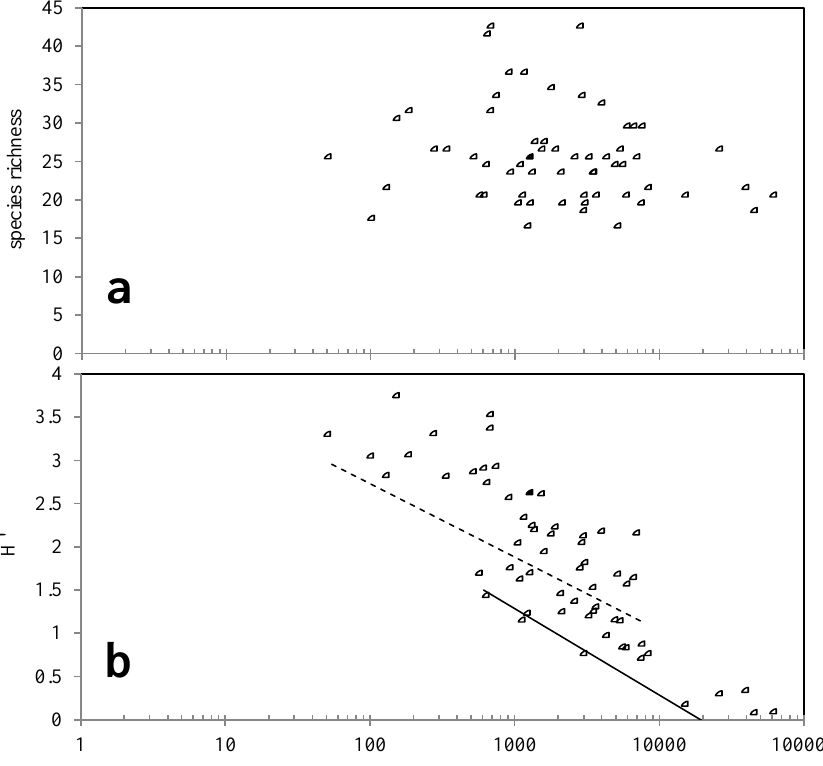
Figure 5. Scatterplots of phytoplankton biomass and phytoplankton diversity expressed as species richness ( a ) and Shannon diversity index H ′ ( b ). Black circles represent measurements of biomass and diversity recorded daily from samples collected in the Lafayette River from 20 April to 25 May 2006. White circles represent algal biomass and diversity measurements recorded at 14 Chesapeake Bay Program Monitoring stations in Virginia during April and May 2006. There was a significant negative linear relationship between species diversity and phytoplankton biomass for both datasets ( p < 0.0001) ( b ). The solid line shows the relationship for the Lafayette River samples and the dashed line shows the relationship for the Chesapeake Bay Program